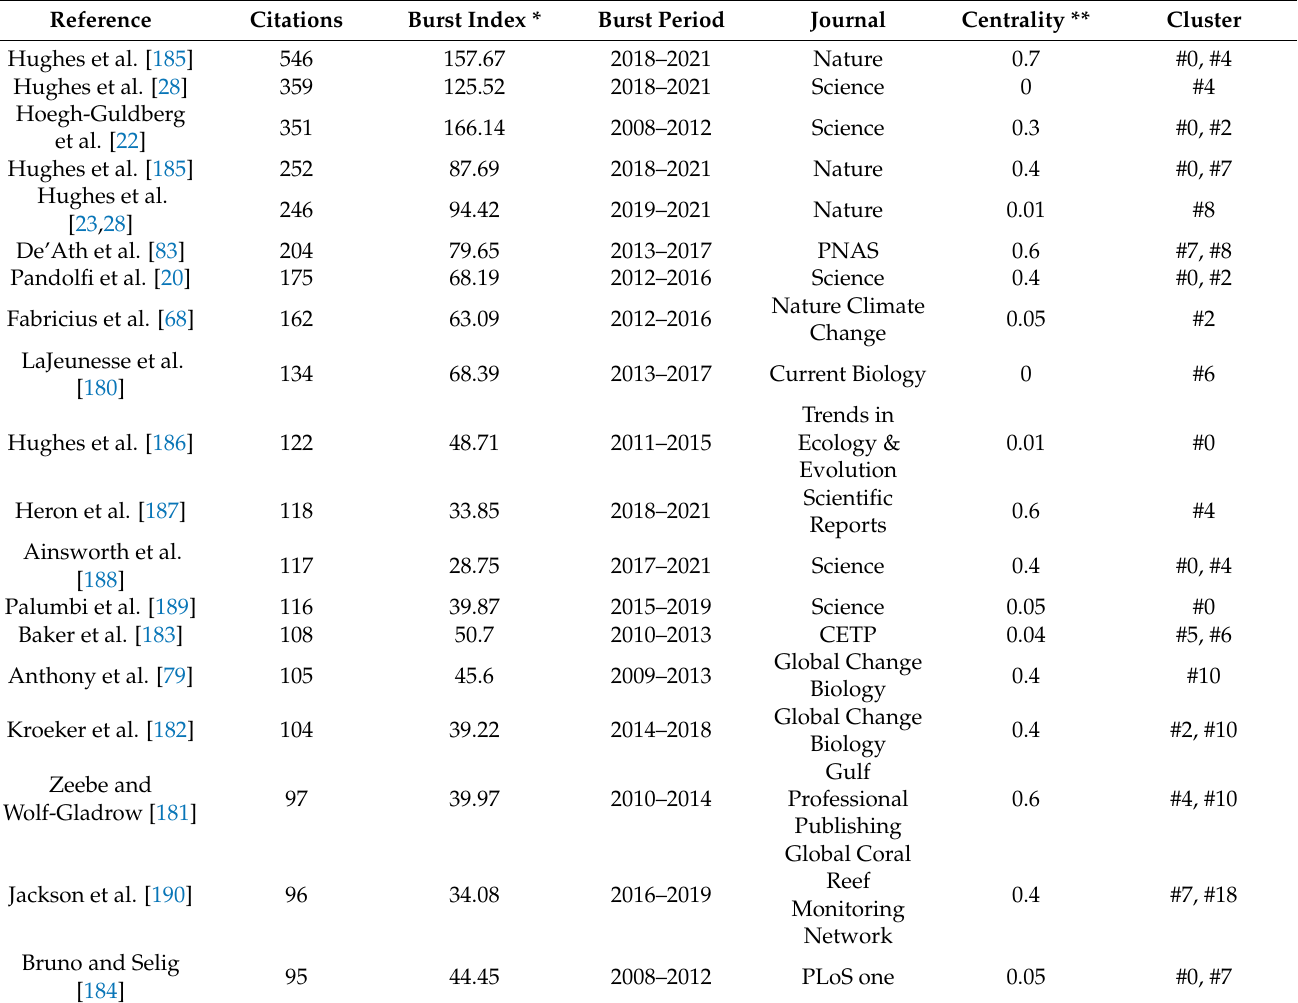
Table 4. The most highly cited references about coral reefs and climate